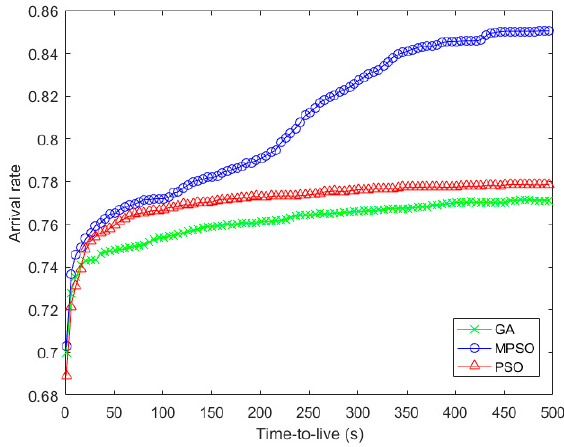
Figure 10. Comparison of arrival rate with the iteration times.